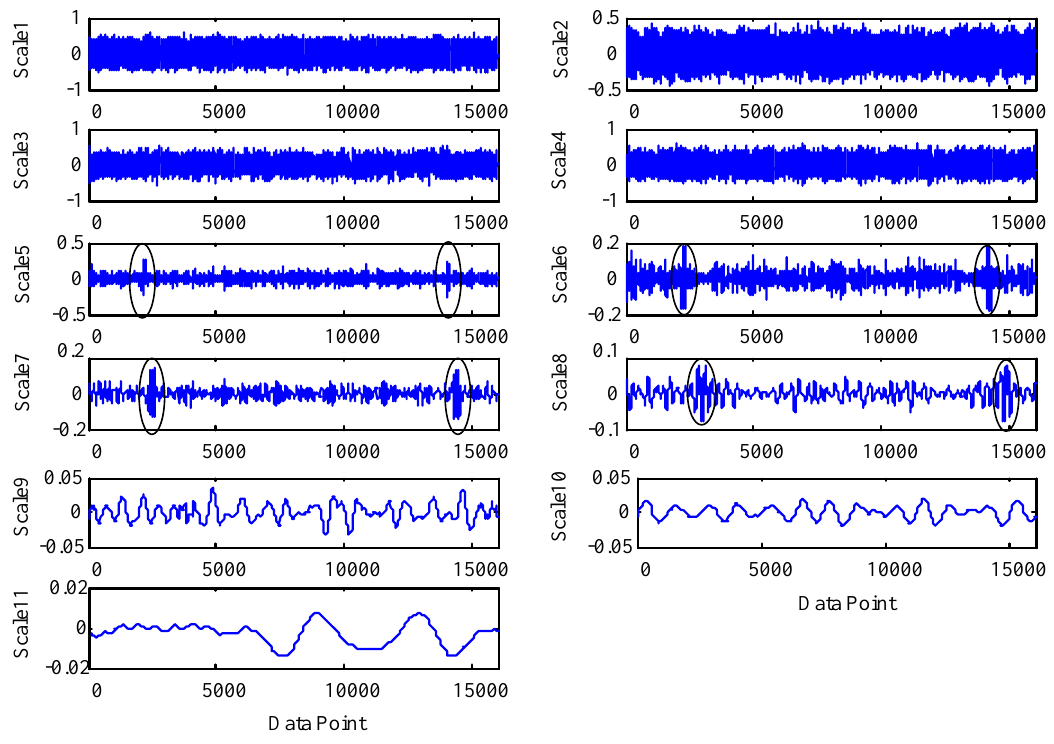
Figure 4. The MODWT coefficients of each scale. For convenience, the profile coefficients of the scale 10 are marked as “scale 11”. At each scale, coefficients related to particle signatures are highlighted using circles.